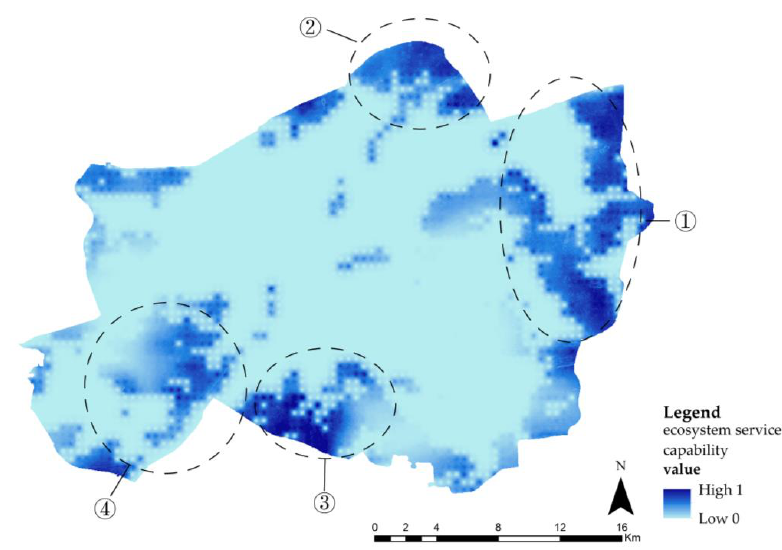
Figure 5. Distribution of the water conservation capacity.